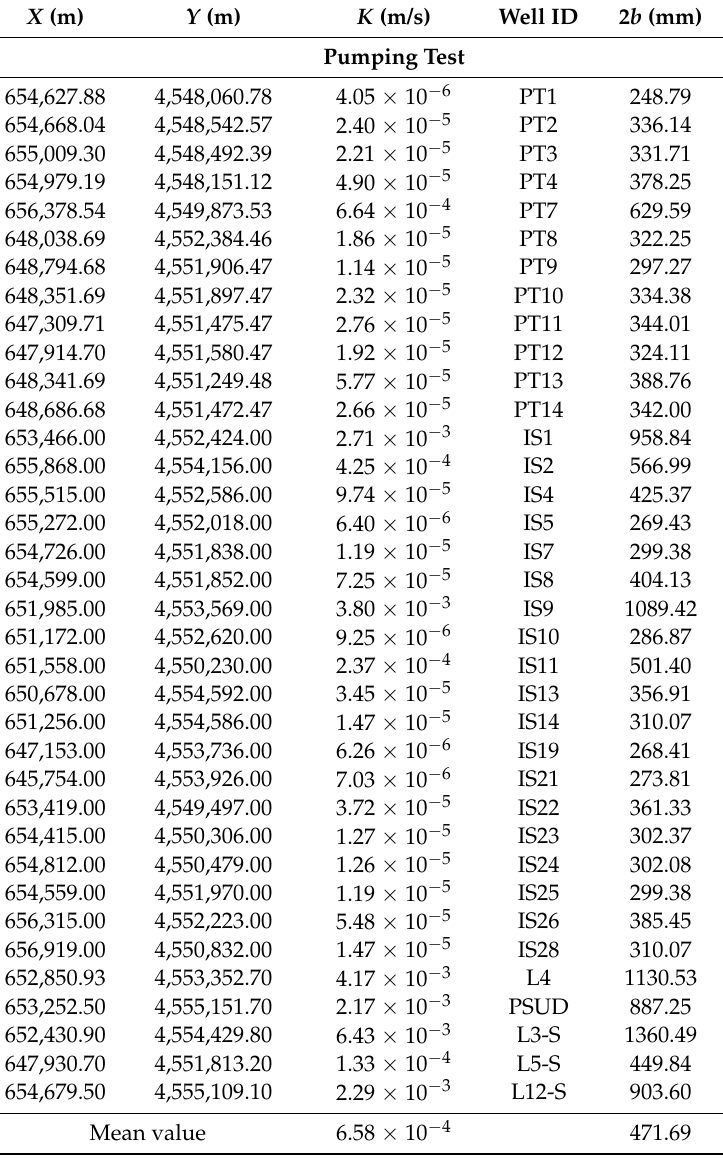
Table 1. Estimations of the mean fracture apertures at the Bari coastal aquifer, by inverting the solution of the steady radial water flow to a well during